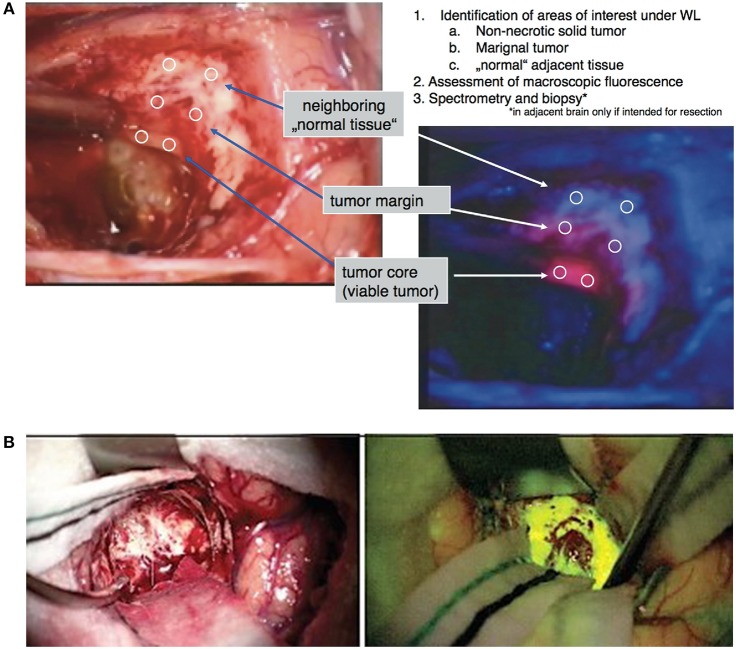
Examples of visible light fluorophores used in brain tumor resection. (A) 5-ALA is an oral prodrug that is converted to proptoporphyrin-IX, a visible light fluorophore with red emission, in high-grade neoplastic cells. Under blue-light excitation (400–410 nm), pink areas correspond to areas of neoplasm against the dark-blue background (28). (B) Fluorescein is a visible-light fluorophore with yellow emission that highlights areas of blood-brain-barrier damage. When injected intravenously 1–3 h prior to tumor exposure, areas of tumor can be visualized in yellow using yellow-green (460–500 nm) excitation (38).